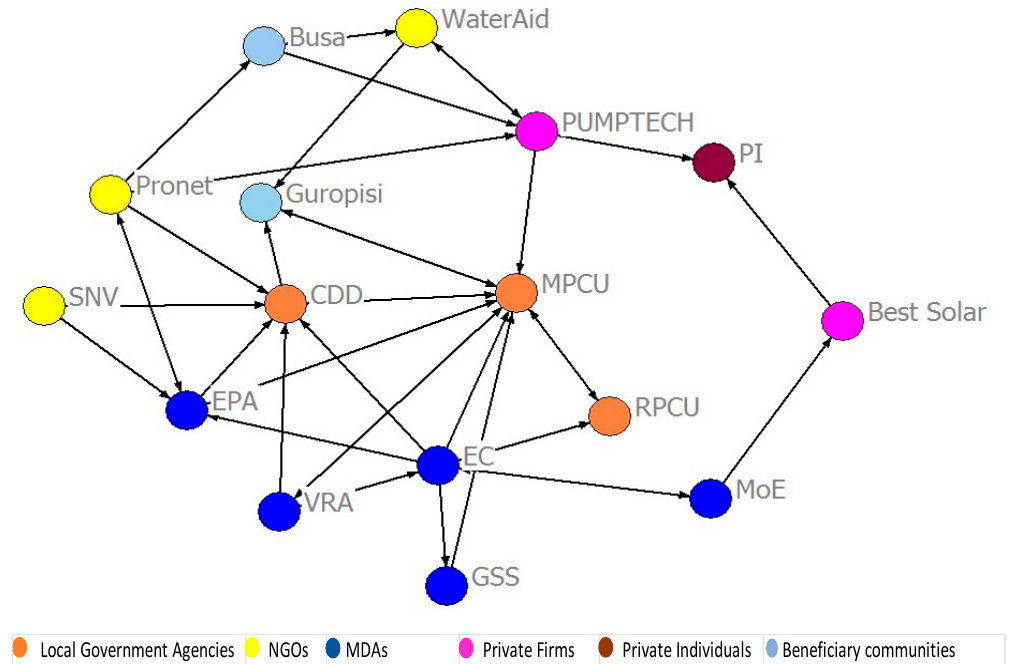
Figure 3. The sustainable energy actor-network in the Wa municipality (Source: Authors’ conception, created with the NETDRAW component of UCINET 6 [49].